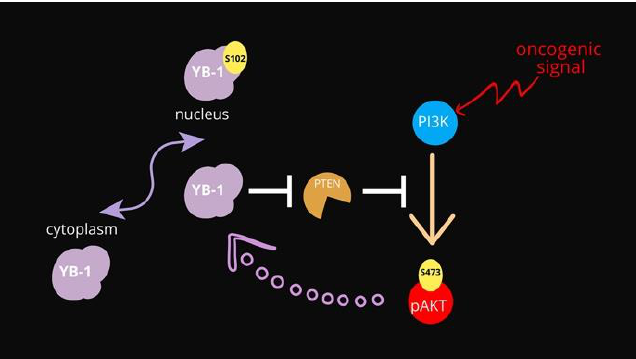
Figure 5. Schematic representation of the proposed functional relationships among YB-1, PTEN and Akt. In normal conditions, YB-1 is mainly cytoplasmic. The Akt-dependent phosphorylation of YB-1 at S102 promotes its translocation to the nuclear compartment promoting cell survival.